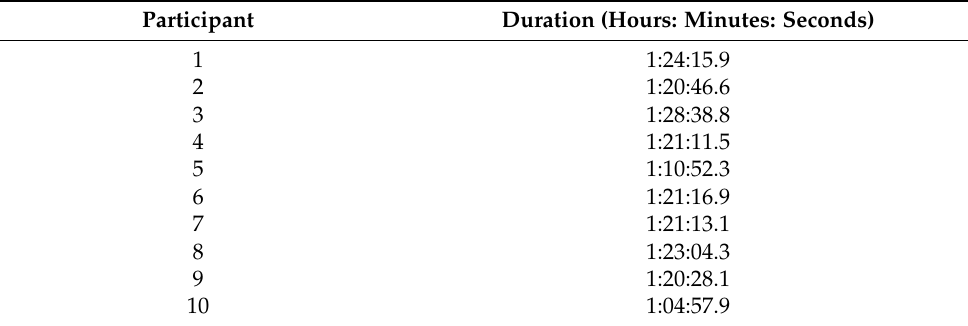
Table 1. EMG signals duration for each participant. Participant